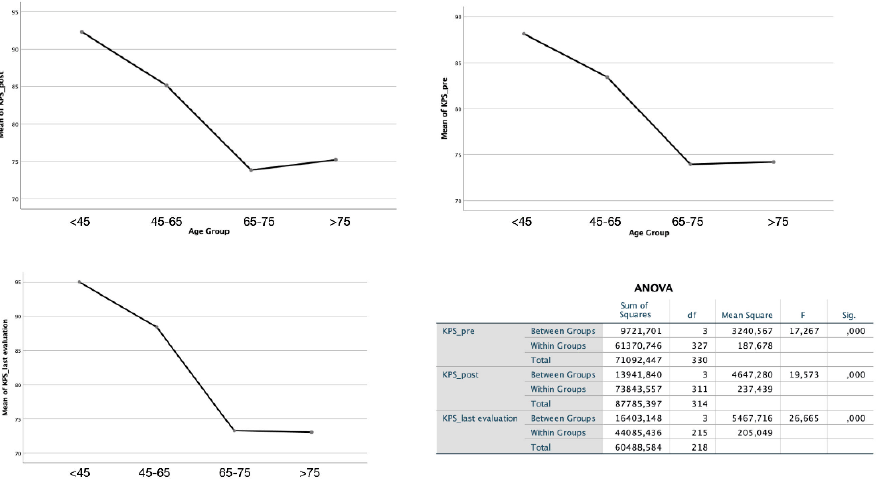
Figure 5. ANOVA study performed on the four age groups shows a significantly lower KPS value in patients over 65 years old. Further, recovery of neurological function and performance grade after the surgical procedure remained consistently lower in the elderly group both in the postoperative phase and in the last evaluation at follow-up (both p < 0.01).